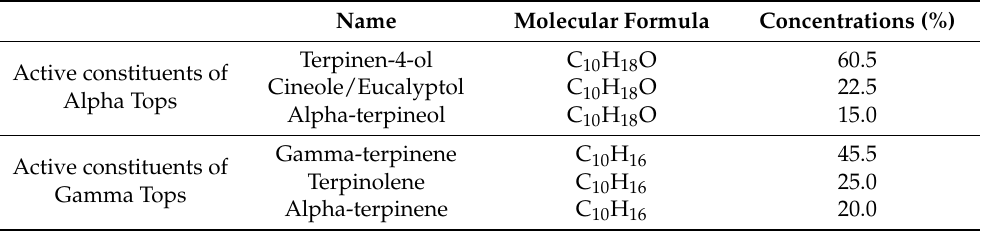
Table 1. Active constituents of Alpha Tops and Gamma Tops used in this study.